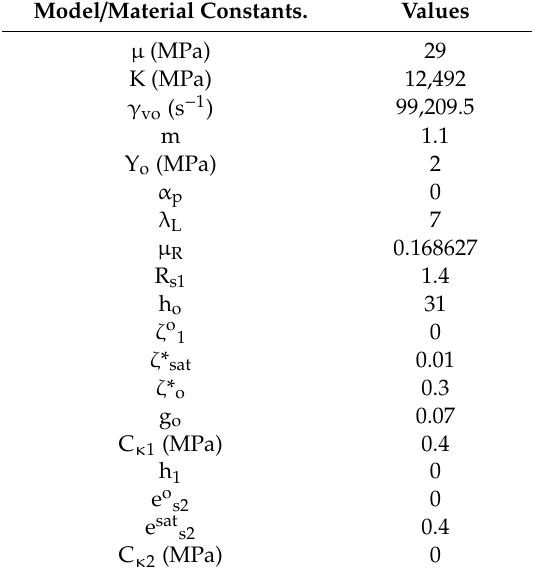
Table 1. Values of material constants for liver material using the MSU TP 1.1 model. Model / Material